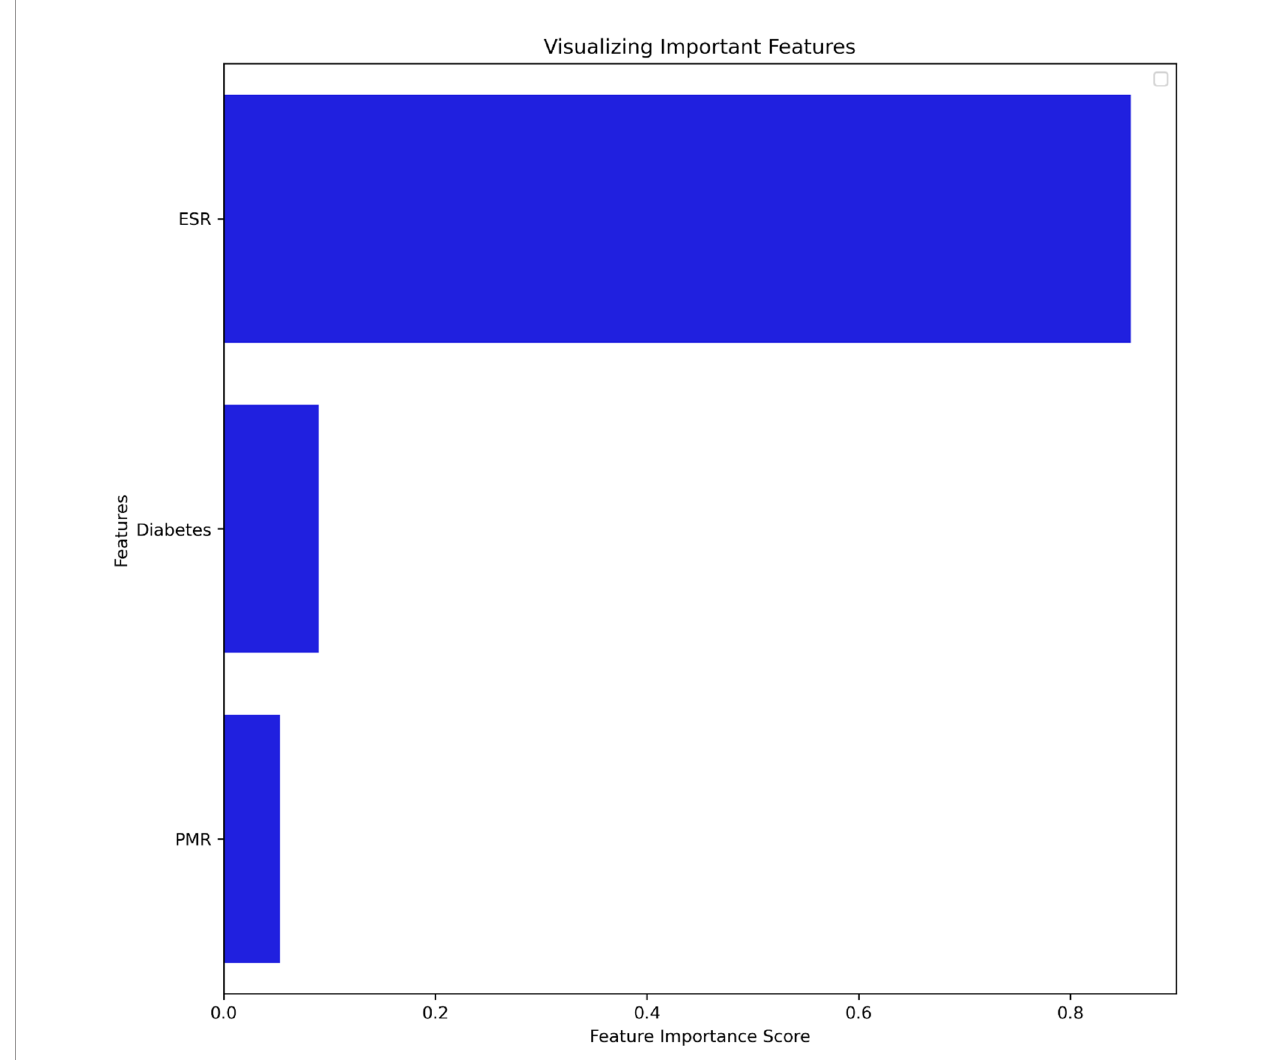
FIGURE 1 | Attribute core set used for training and validation of the algorithms ranked for feature importance score. DM, Diabetes mellitus; ESR, Erythrocyte Sedimentation Rate; PMR, Polymyalgia